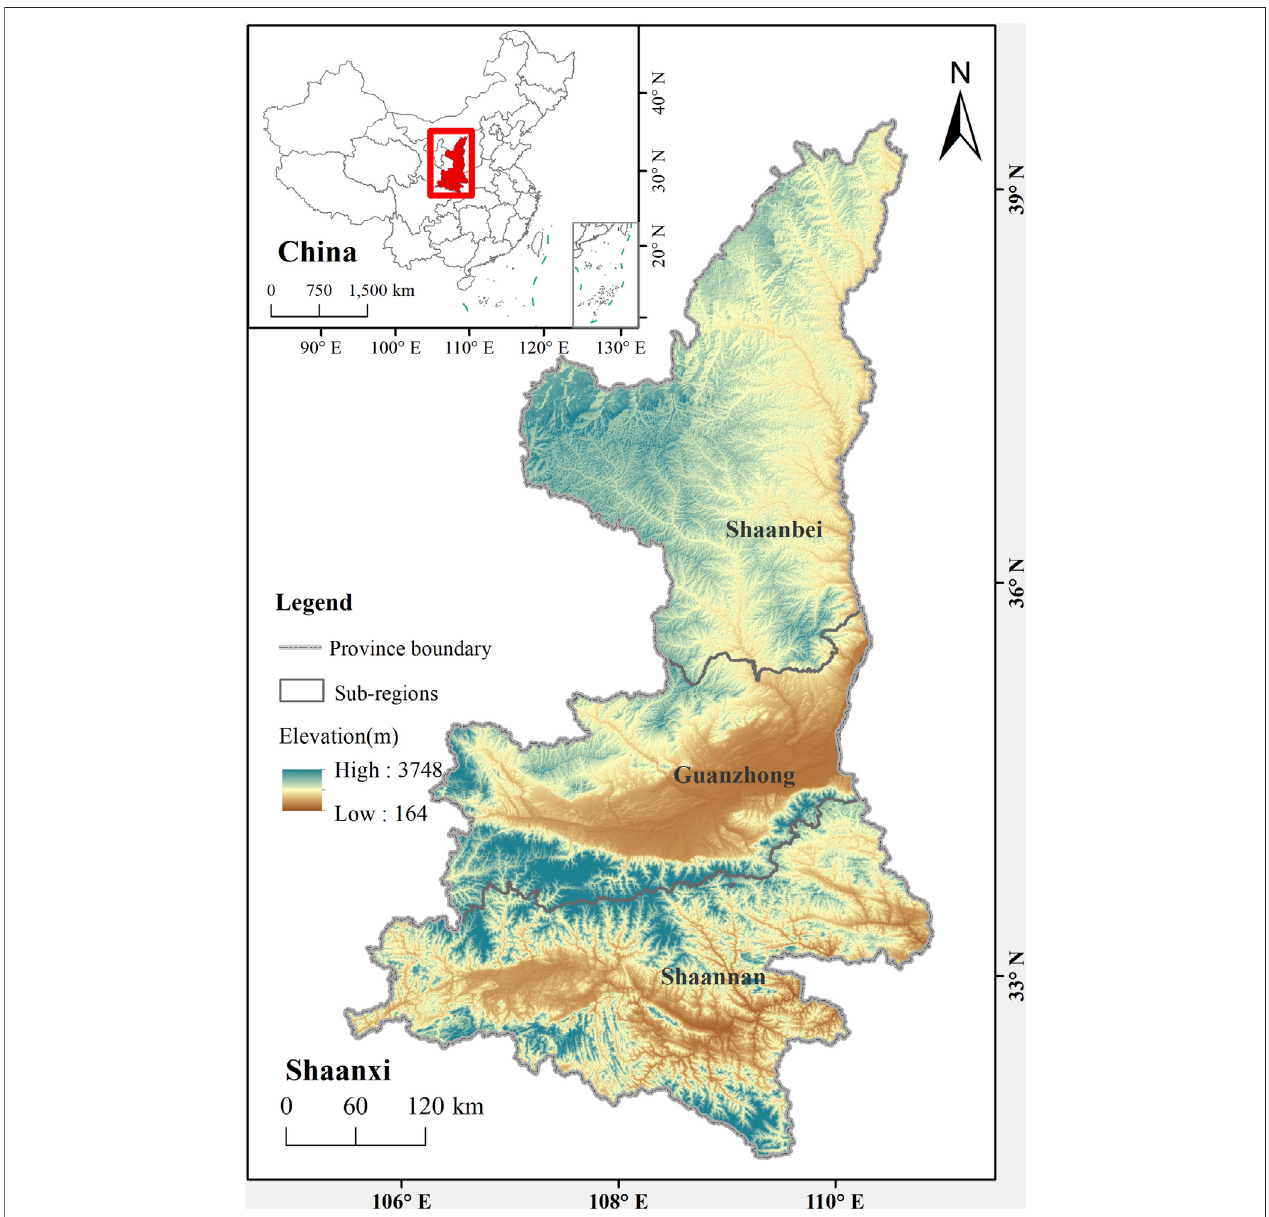
FIGURE 1 | Location of the study